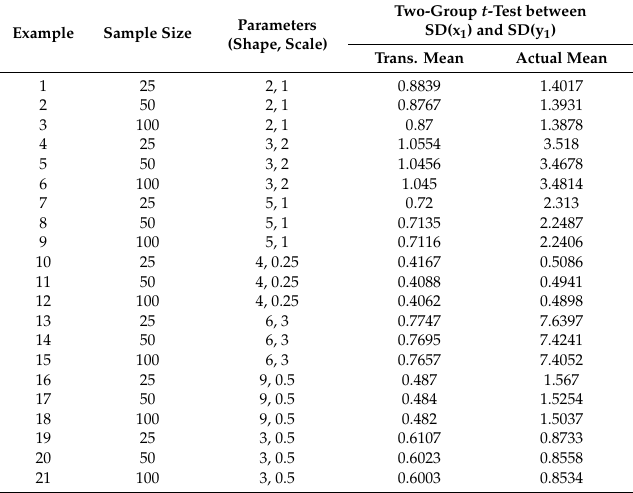
Table 6. Standard deviation estimates for the original and log-transformed gamma-distributed data.